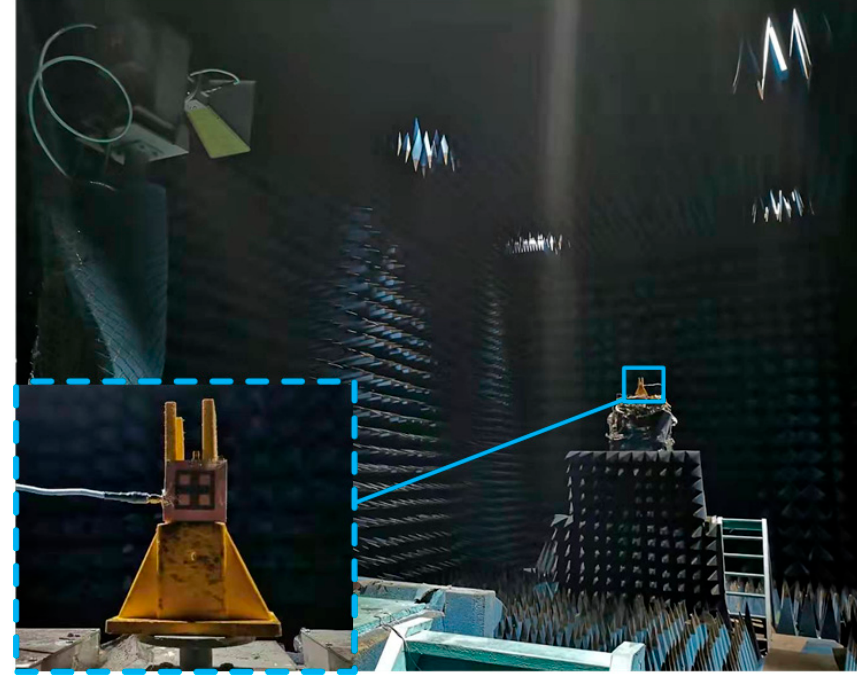
Figure 12. Photograph of the test system.